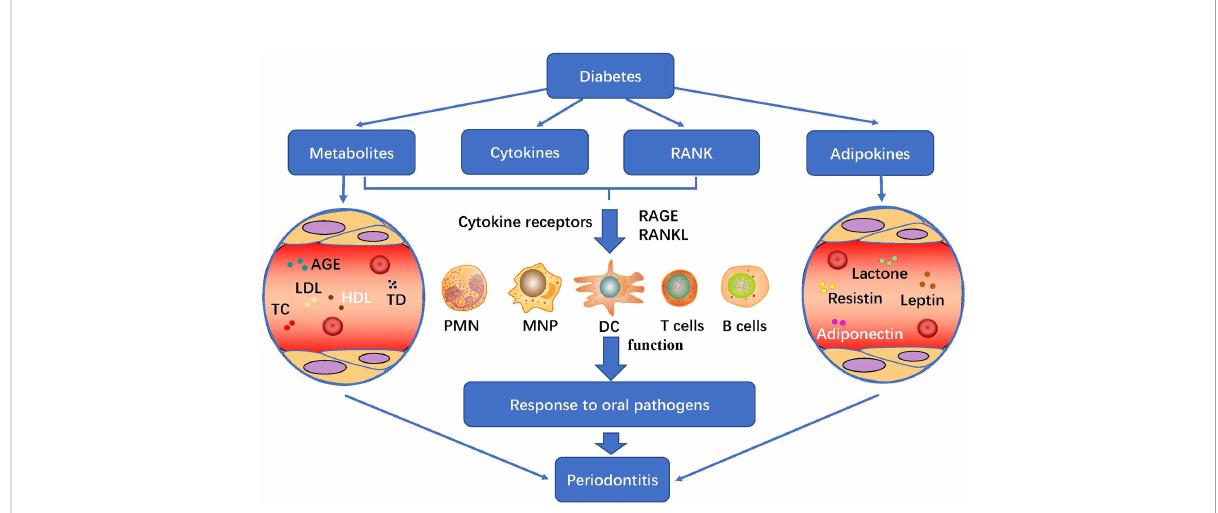
FIGURE 3 Diabetes metabolism and its immune regulation effect on periodontitis: diabetes regulates the host ’ s response to periodontal pathogens by changing its structure and metabolites AGE, fat factor, cytokines, bone metabolism and immune response, and participate in the immune regulation of diabetes to periodontitis micro fl ora. PMN, polymorphonuclear neutrophil; MNP, mononuclear phagocytic cells; DC, dendritic cells; PRRs, pattern recognition receptors; TLRs, Toll-like receptors; RANK, Receptor activator of NF- k B; AGEs, advanced glycation end products; LDL, low density lipoprotein; HDL, high density lipoprotein; TC, total